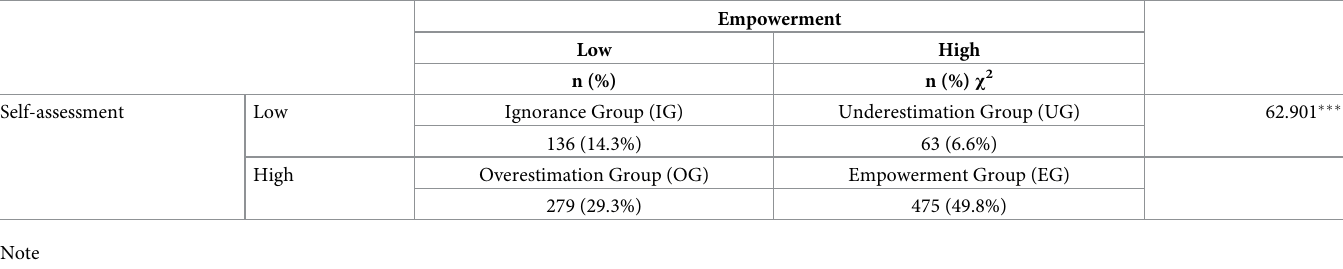
Table 2. Distribution of participants among consumer